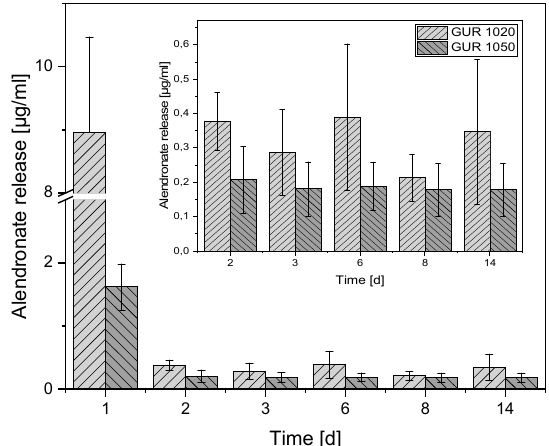
Figure 7. AL release overview; the smaller diagram is an enlargement of our day 2–14 findings to facilitate comparison [N = 30].